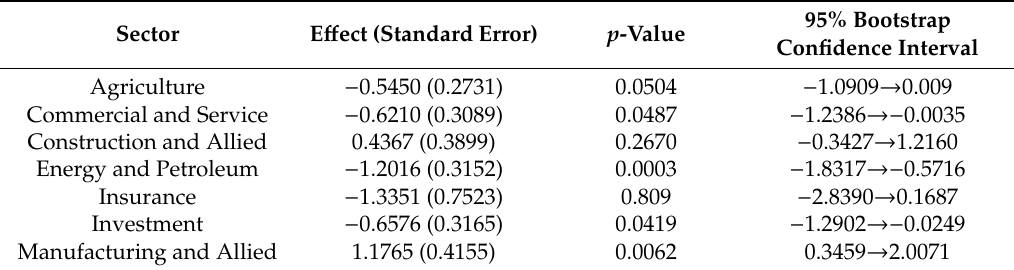
Table 3. E ff ect estimates of the relative direct e ff ects of di ff erent business sectors on firm financial performance based on Process Macro